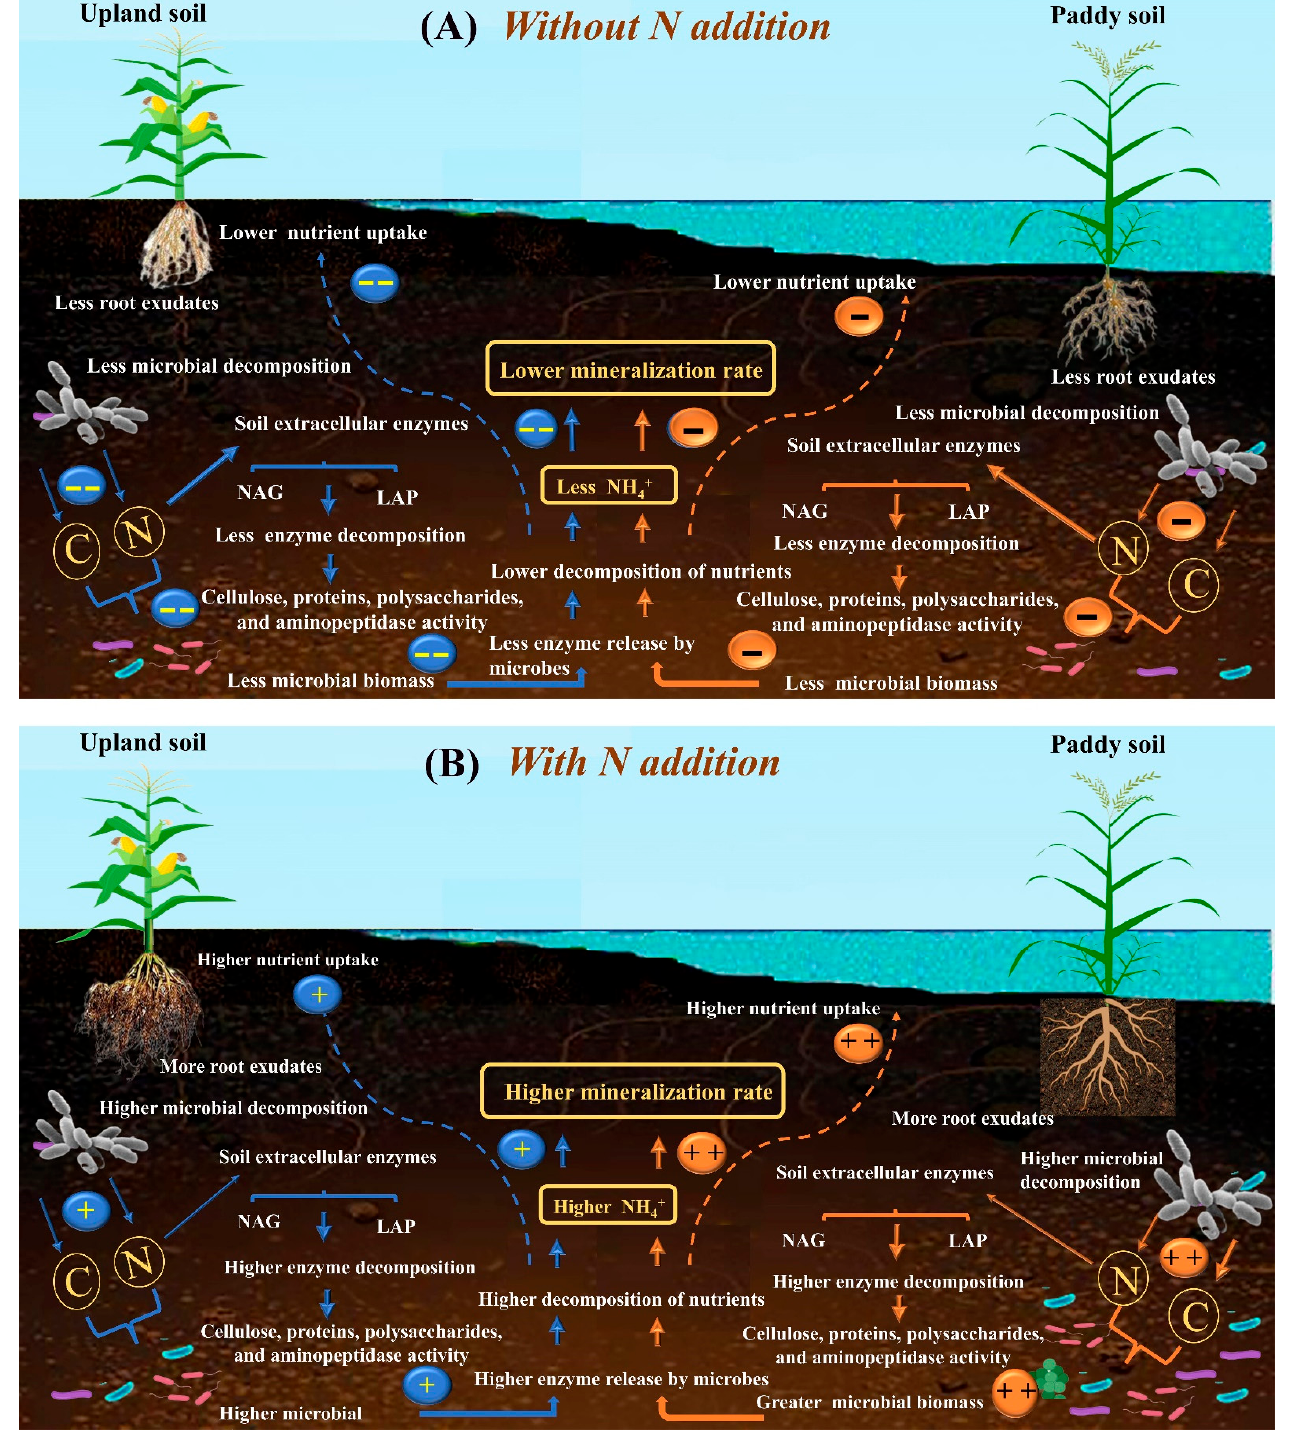
Figure 7. A diagram illustrating N content, microbial biomass and nutrient availability in soil and how soil organic matter, microbial biomass and extracellular enzymes influence N mineralization processes. Blue arrows show the processes in upland soil, while orange arrows show processes in paddy soil. ( A ) The figure represents the transformation processes in “without N addition” soils, “-” and “--” indicate the comparison between the soil microbial biomass, enzyme activity and mineralization rate in upland and paddy soils, respectively. ( B ) The figure represents the transformation processes in “with N addition” soils, while “+” and “++” indicate the comparison between the microbial biomass, enzyme activity and mineralization rate in upland and paddy soils, respectively.